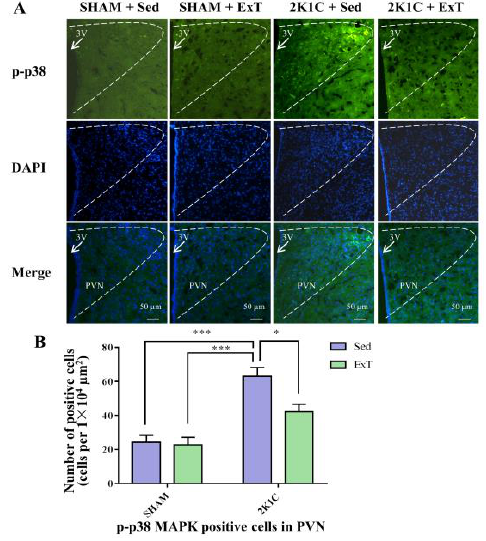
Figure 7. Eight weeks of aerobic ExT attenuated PVN level of p-p38 MAPK immunoreactivity in 2K1C group. ( A ) Representative immunofluorescence staining of p-p38 MAPK. ( B ) Densitometric analysis of immunofluorescence staining of p-p38 MAPK. 3V: third ventricle. * p < 0.05, *** p < 0.001, n = 4.